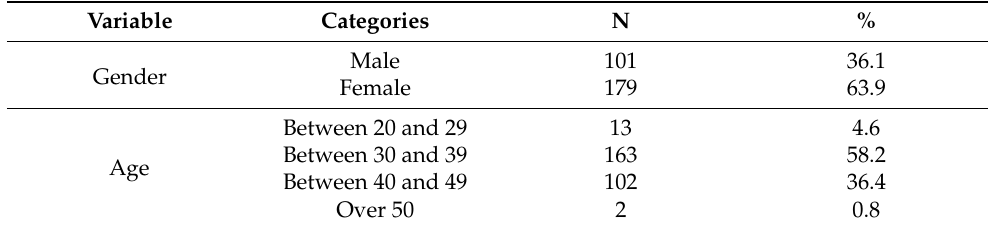
Table 1. Parental characteristics (N = 280).